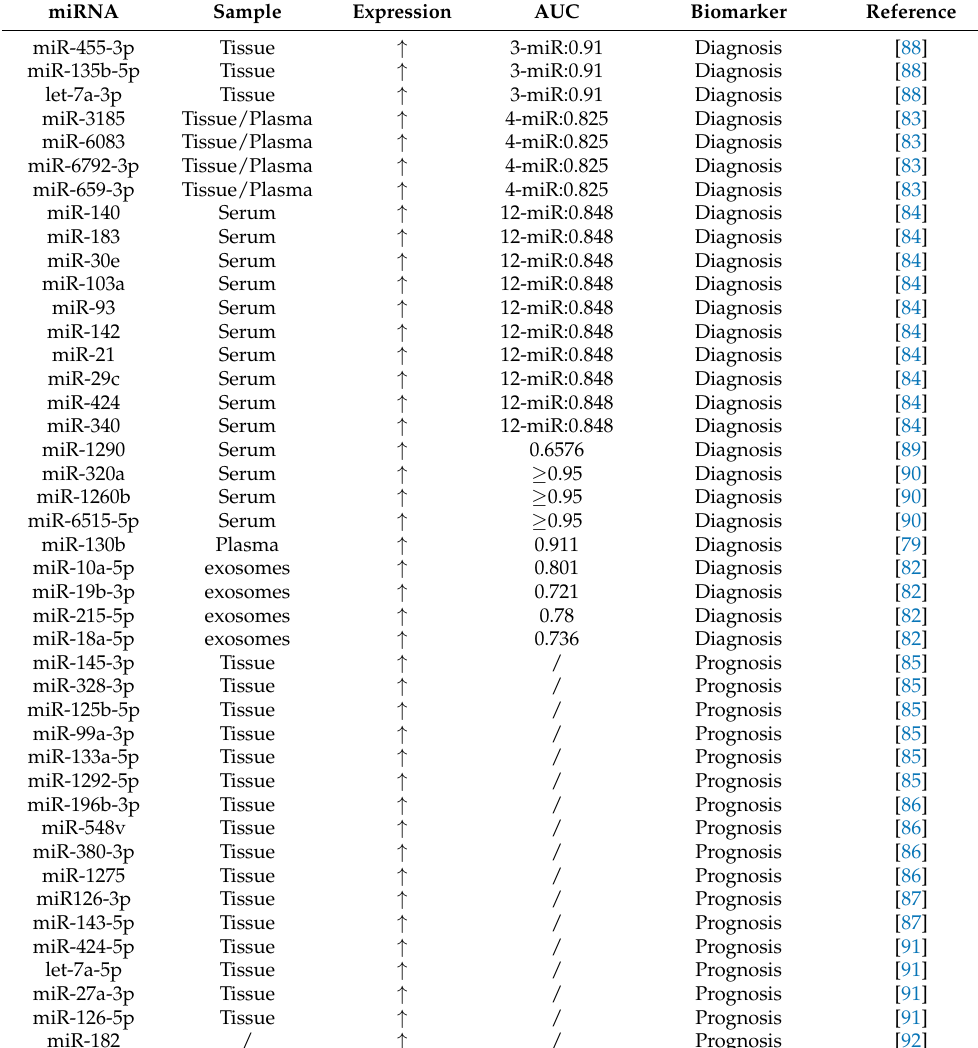
Table 3. MicroRNAs as biomarkers for diagnosis and prognosis of GC. miRNA